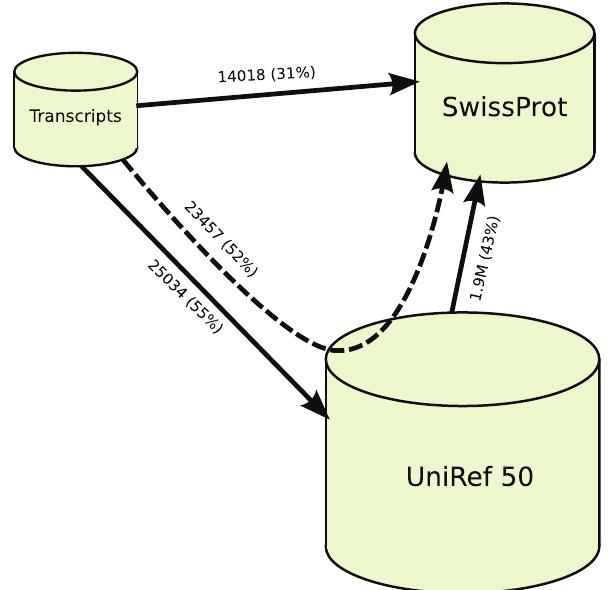
Figure 4. Sequence databases, and the number of query sequences with BLAST hits, using an E -value threshold of 10 { 4 . Numbers in parentheses indicate the percentage of query sequences with BLAST hits, transitive alignments are represented by the dashed arrow.